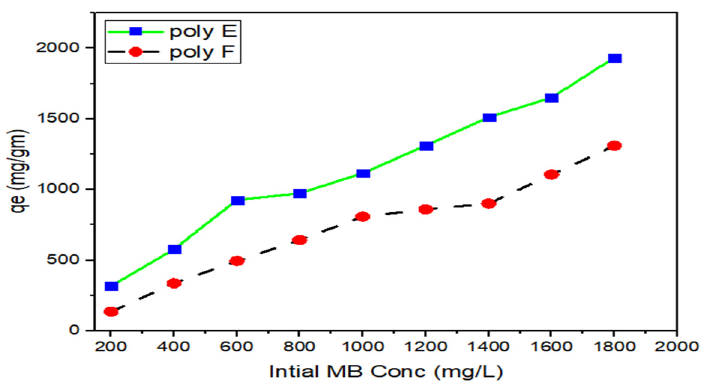
Figure 11. Effect of initial MB concentration on both polymer F and polymer E for MB adsorption. Experimental conditions were: adsorbents hydrogel dose 50 mg in 100 mL; pH 7, and RT.